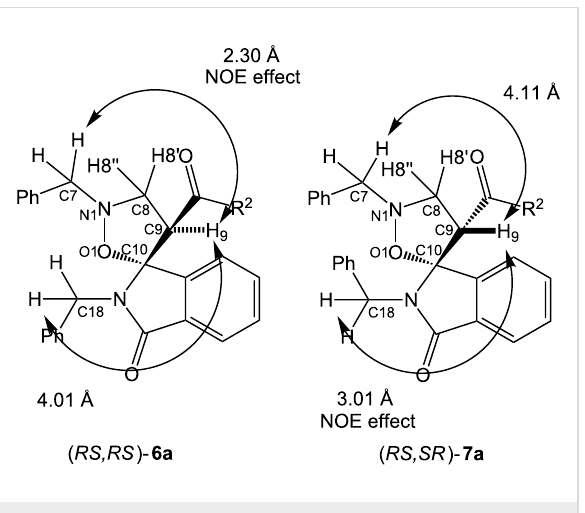
Figure 3: Selected NOESY observed for compounds 6a and 7a .